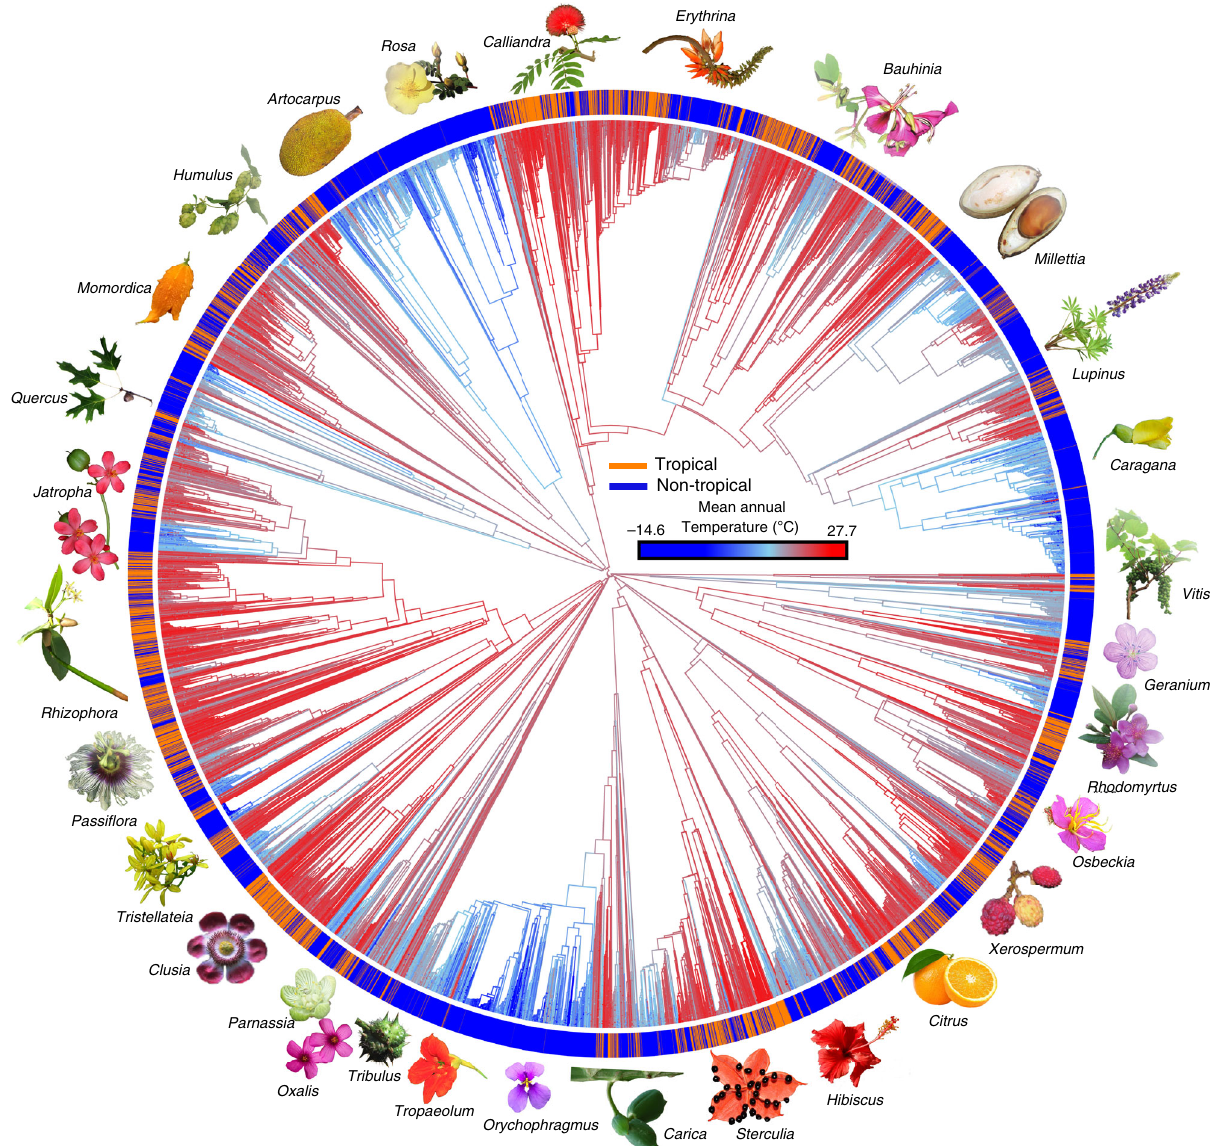
Fig. 1 Ancestral reconstruction across the rosid tree for mean annual temperature. Branches are colored based on mean annual temperature from low ( − 14.6 °C; blue) to high (27.7 °C; red) values. Species tips are colored by the Köppen – Geiger climatic classi fi cation 43 ; orange represents tropical species, and blue represents non-tropical species, based on climatic criteria; we also represent rosid diversity using icons ( fl ower, fruit, leaves) of clade members to conceptually re fl ect their morphological character diversity, tropicality, and economic importance; a genus name is provided with each associated